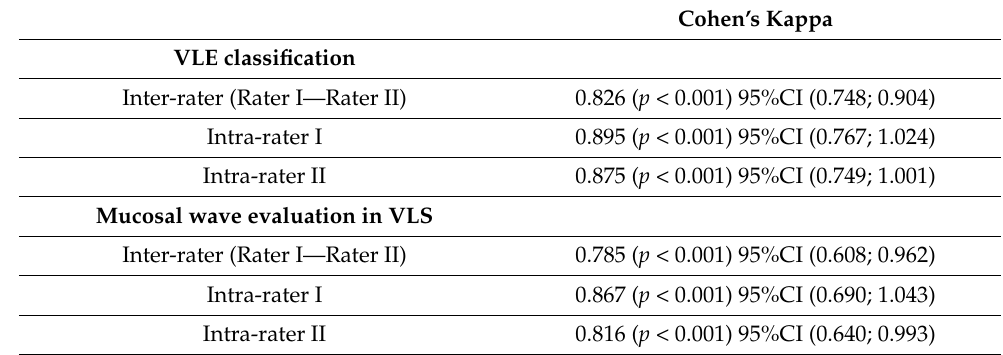
Table 3. The inter-rater agreement (between Rater I and Rater II) and intra-rater agreement in the evaluation of: the leukoplakia plaque morphology according to Chen (2019), and a mucosal wave presence on the vocal